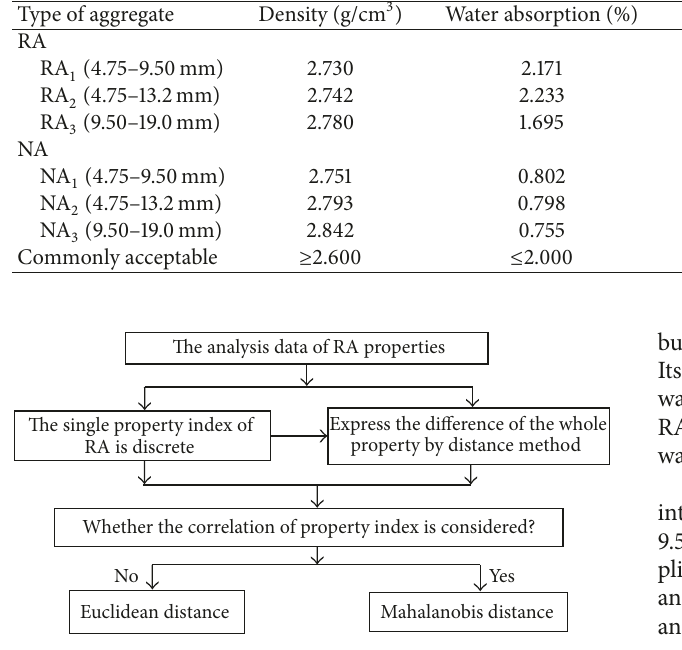
Figure 1: RA property evaluation flow